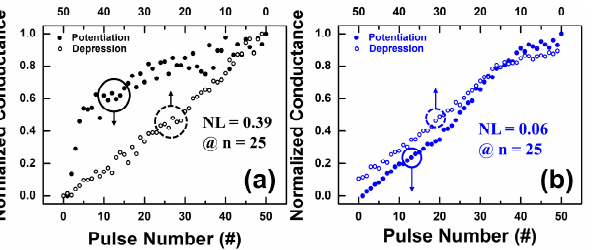
Figure 10. Normalized synaptic characteristics for the potentiation and depression processes under 50 consecutive non-identical pulses for ( a ) pristine and ( b ) plasma-treated devices.